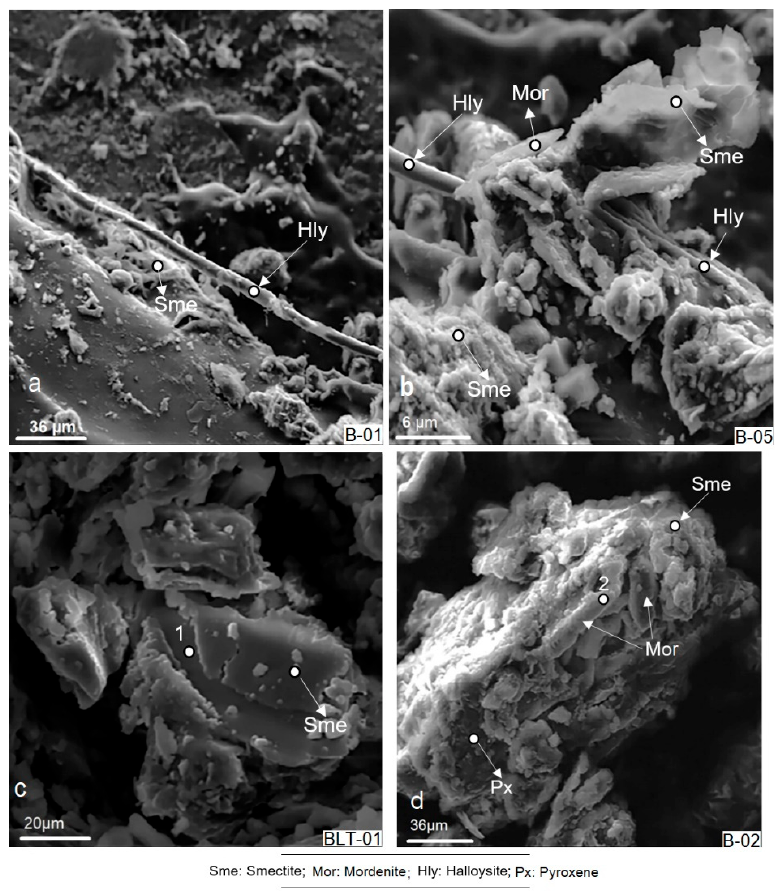
Figure 10. Scanning electron microscopy (SEM) micrographs of the bentonite samples ( a – d ).